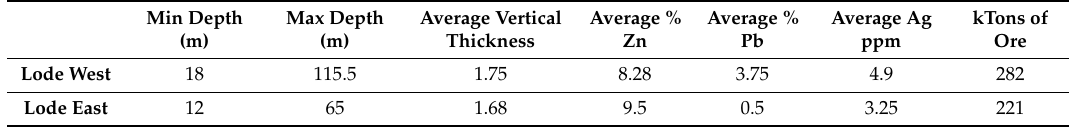
Table 1. Characteristics of the Poppelsberg East and West